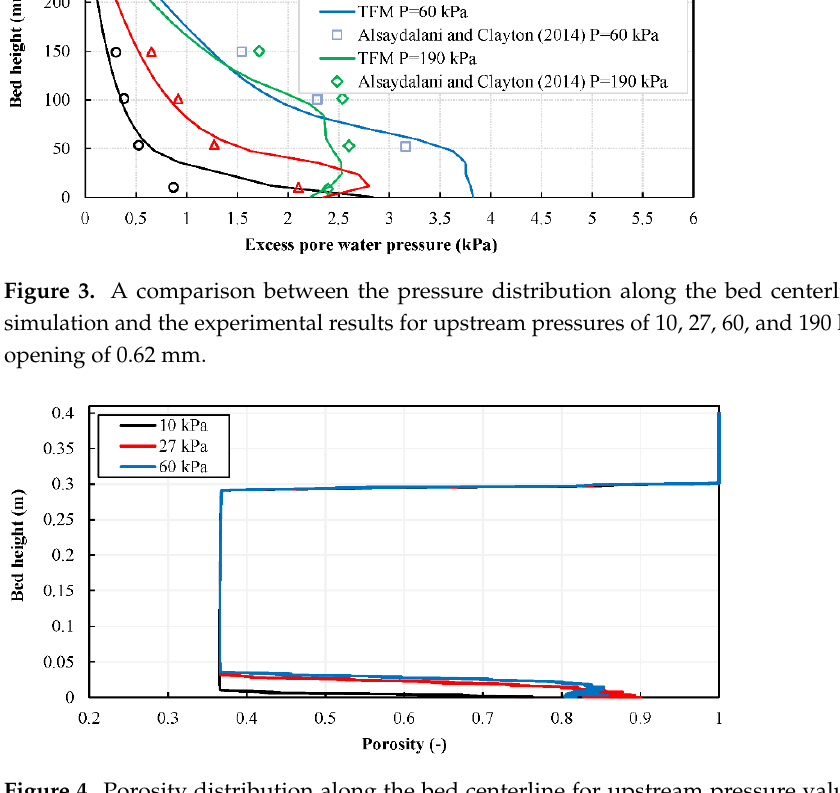
Figure 5. A comparison between the predicted initiation of fluidization and from the TFM simulation and the experimental data.